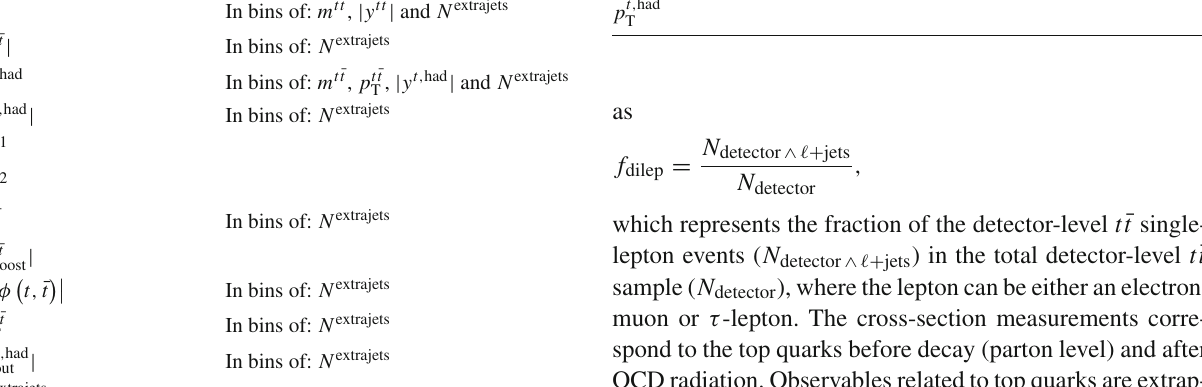
Table 8 The single-differential and double-differential spectra, mea- sured in the boosted topology at parton level 1D observables 2D combinations m t ¯ t In bins of: p t , had p t , had